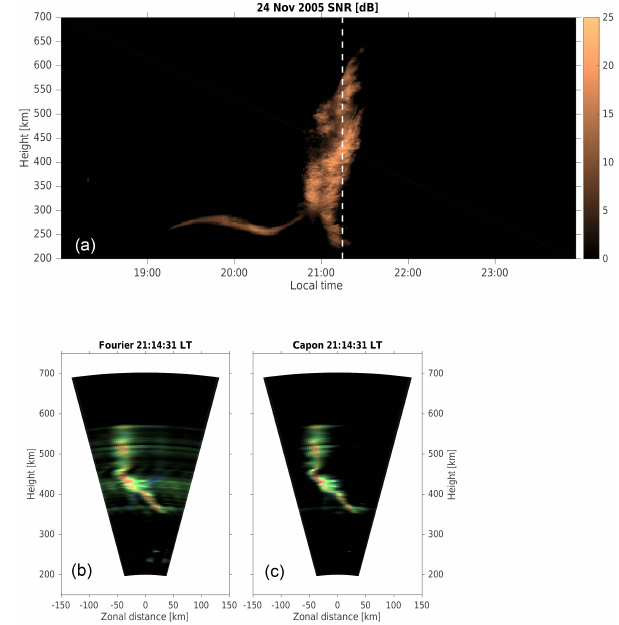
Figure 5. Panel (a) shows the range–time–intensity map of F region observations made by the São Luís radar on 24 November 2005. Panels (b, c) show the images obtained with the Fourier trans- form (b) and Capon methods (c) for observations from 21:14:31LT. Zonal distance is positive to the east. The estimated images are scaled by the SNR of the echoes. The Doppler information is en- coded in the pixel colors. The green components represent small mean Doppler velocities. Red and blue components represent irreg- ularities moving away and towards the radar,